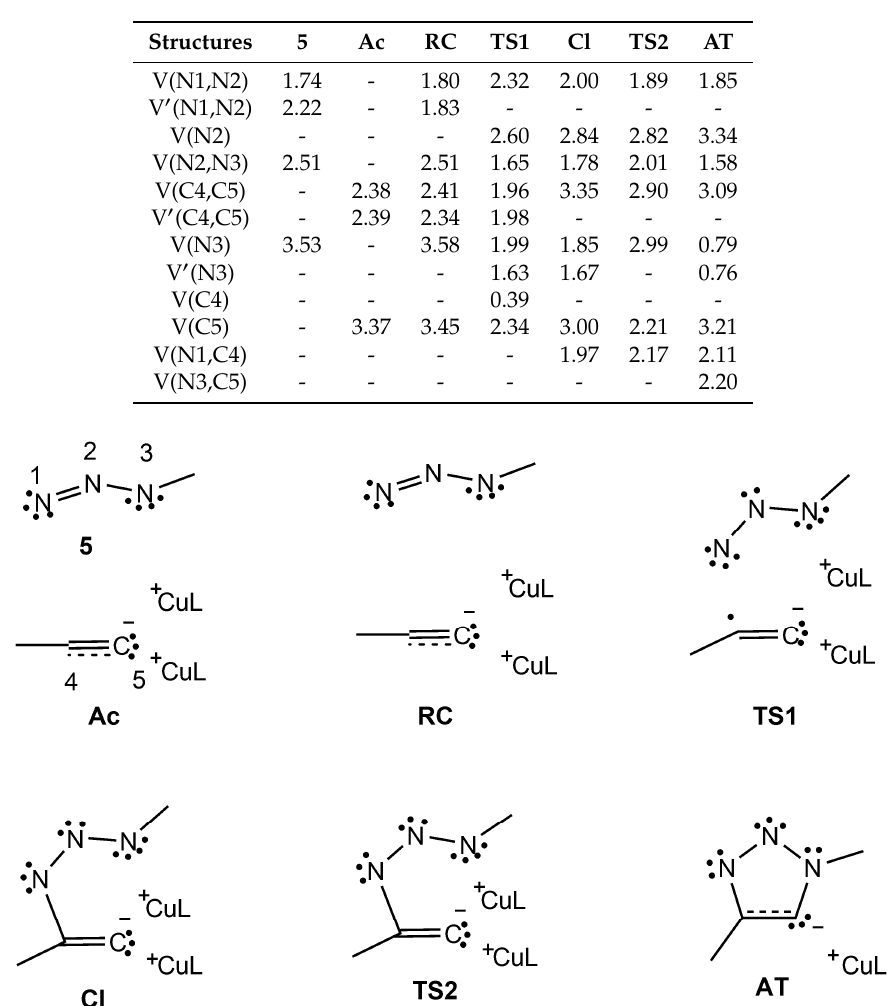
Figure 4. ELF-based Lewis structures of the intermediates involved in the CuAAC reaction of Ac with 5 (L = abt).